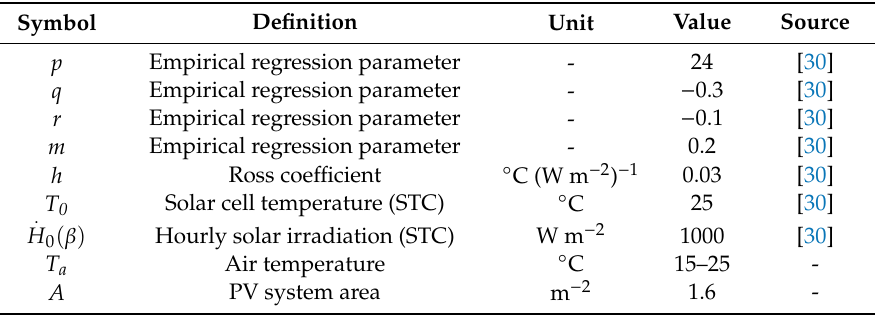
Table A2. PV system model